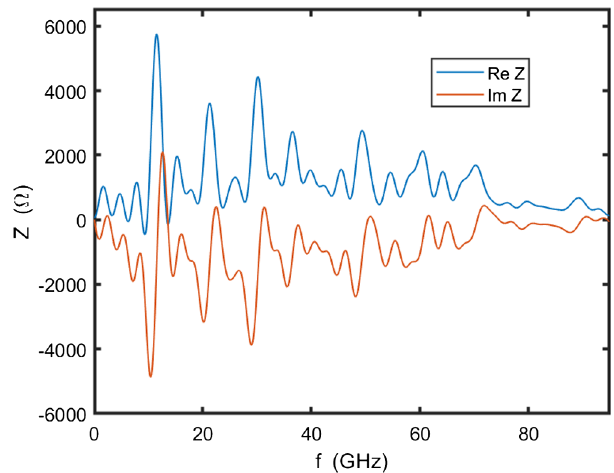
FIG. 12. Fill C2 with HHC only, detuning df ¼ 235 kHz, ¼ 474 . 5 mA. I av